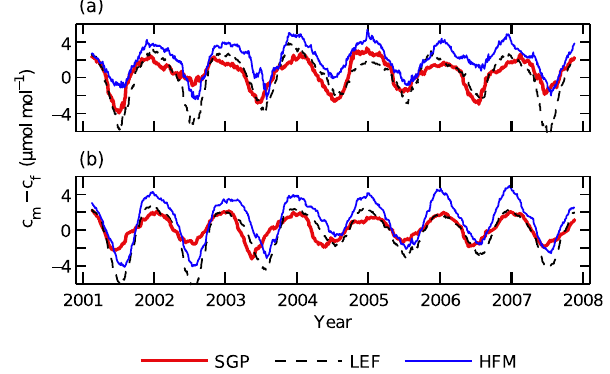
Fig. 6. Vertical mixing ratio gradient inferred from the equilibrium approximation (a) and from the CT/TM5 data assimilation system (b) at SGP (red), LEF (dashed black), and HFM (blue), using 90- day